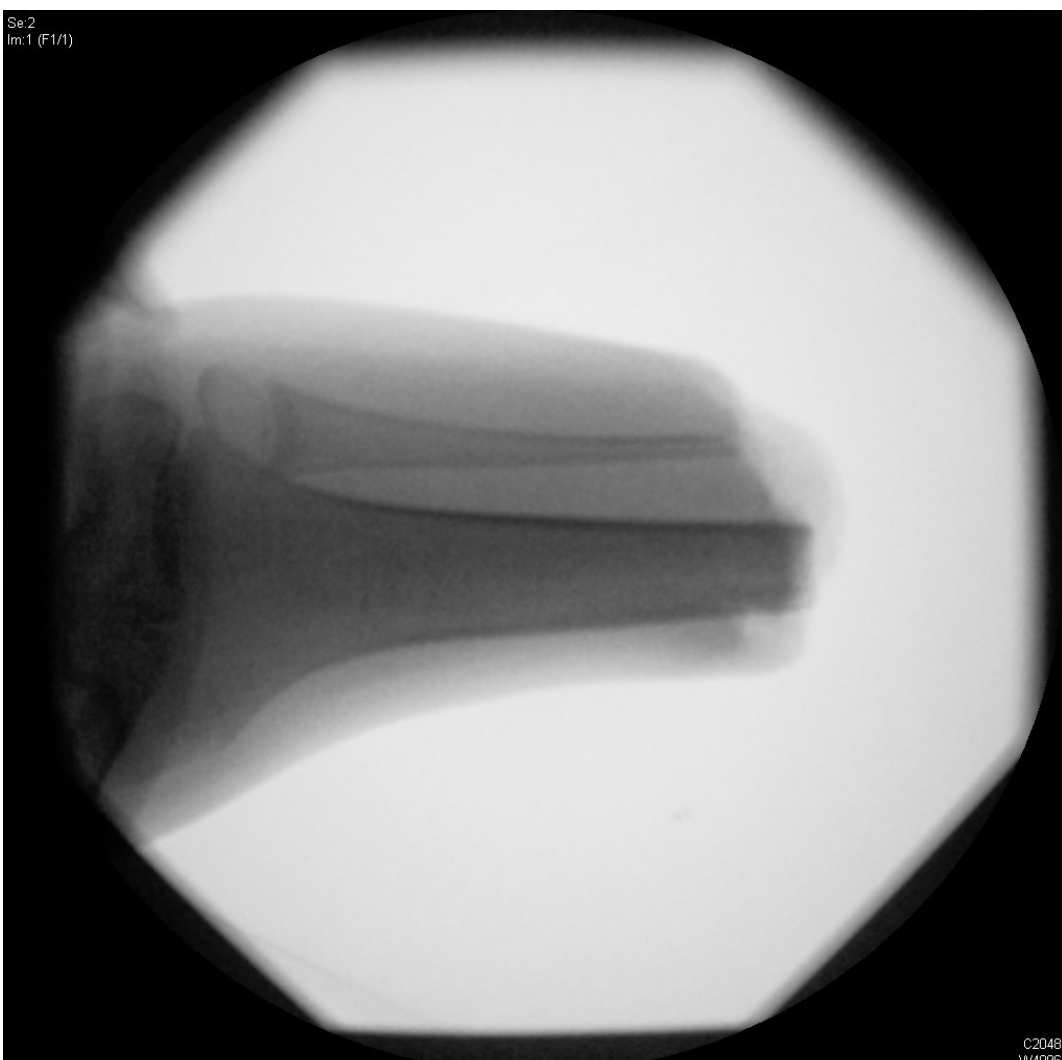
Figure 3. X-ray image of stump spike.